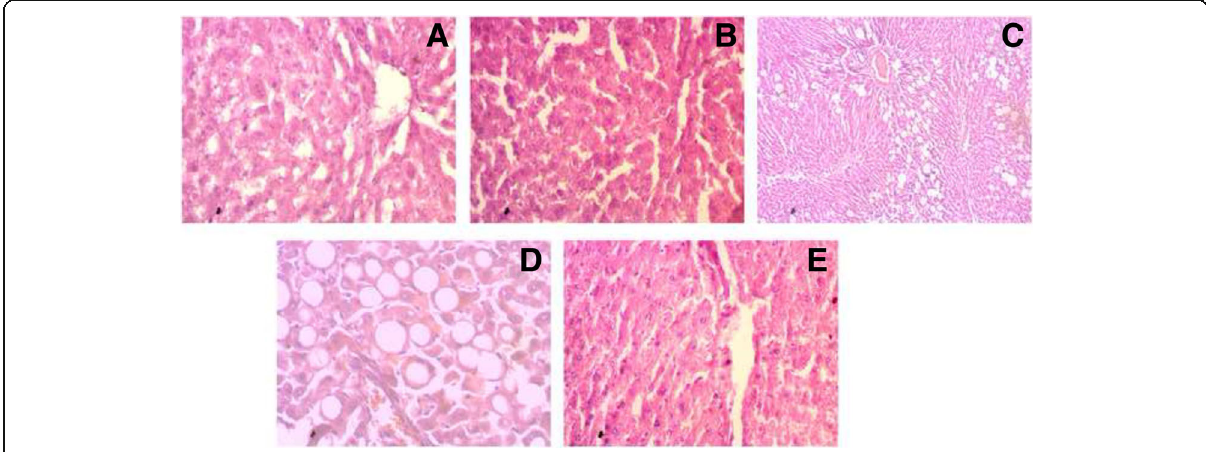
Fig. 4 Effect of Syzygium cumini seed powder supplementation on hepatic inflammation in high fat diet fed obese rats. a Control; b Control + Syzygium cumini seed; c HCHF (low manification); d HCHF (high magnification); e Fat + Syzygium cumini seed. Magnification 40